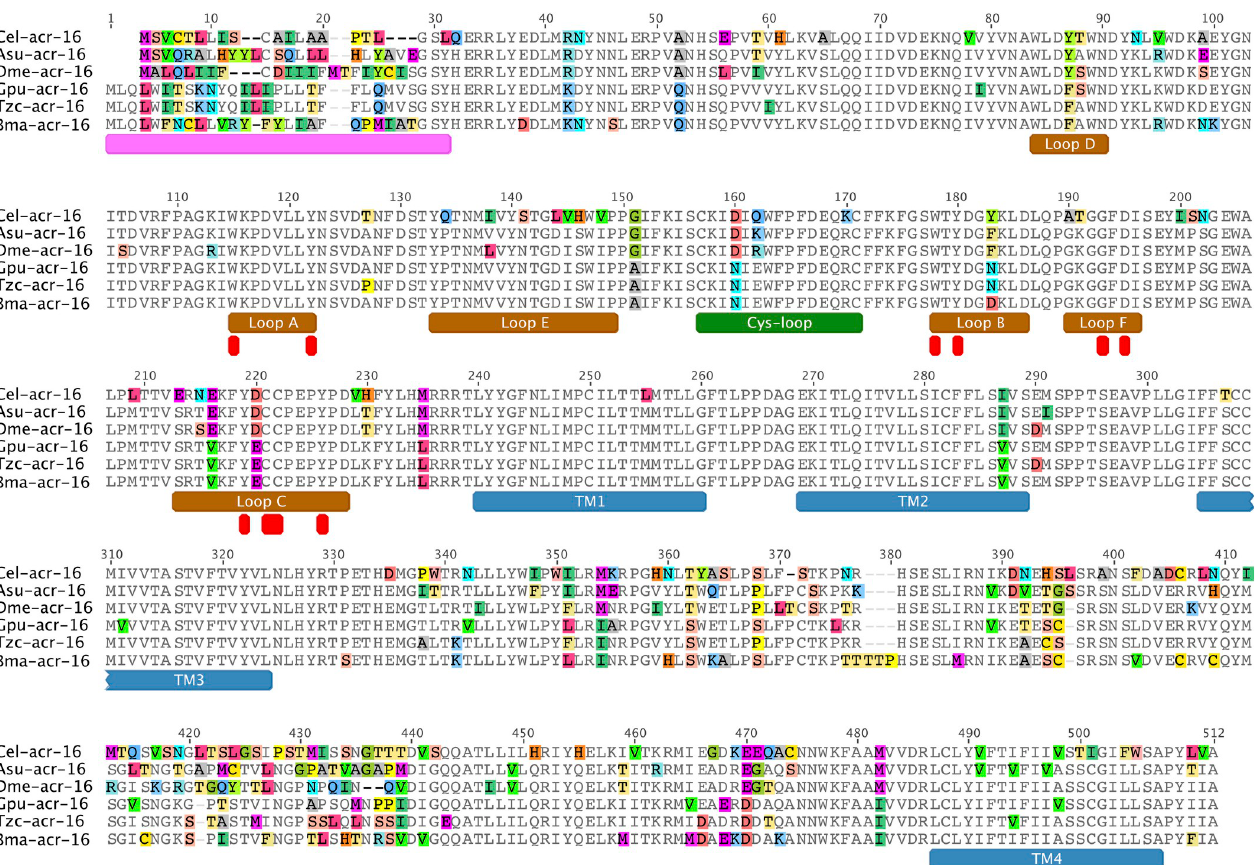
Fig 2. ACR-16 is conserved in clade III worms. Five clade III ACR-16 were used to identify why no B . malayi N-AChR can be measured in oocytes. Predicted coding sequences were synthesized from their respective genomes obtained from WormBase ParaSite WBPS13 [81,87] with primary protein sequence alignment shown. C . elegans ACR-16 was included for reference as it has been previously characterized [1,24]. All functionally important regions and motifs are conserved within the B . malayi sequence and implies that no specific substitutions explain the inability of measuring an N-AChR. Transmembrane domains are shown in blue, signal peptide in pink, acetylcholine binding loops in brown, cys-loop in green and residues that interact with agonist in red [43,44].